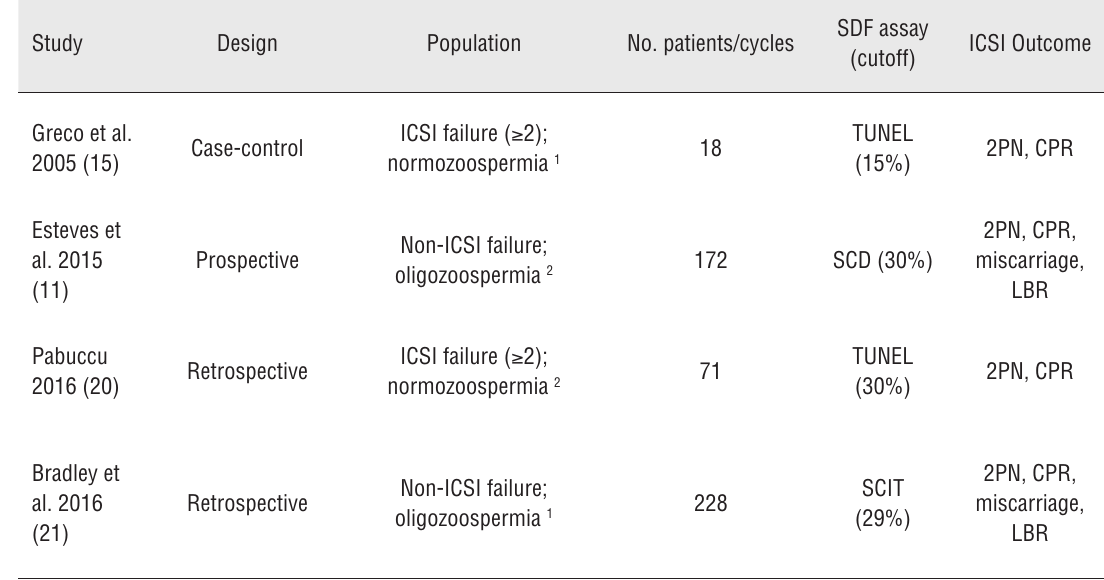
Table 2 - characteristics of studies comparing intracytoplasmic sperm injection (IcSI) outcomes using testicular versus ejaculated sperm in infertile men with high sperm DNA fragmentation (SDf) in